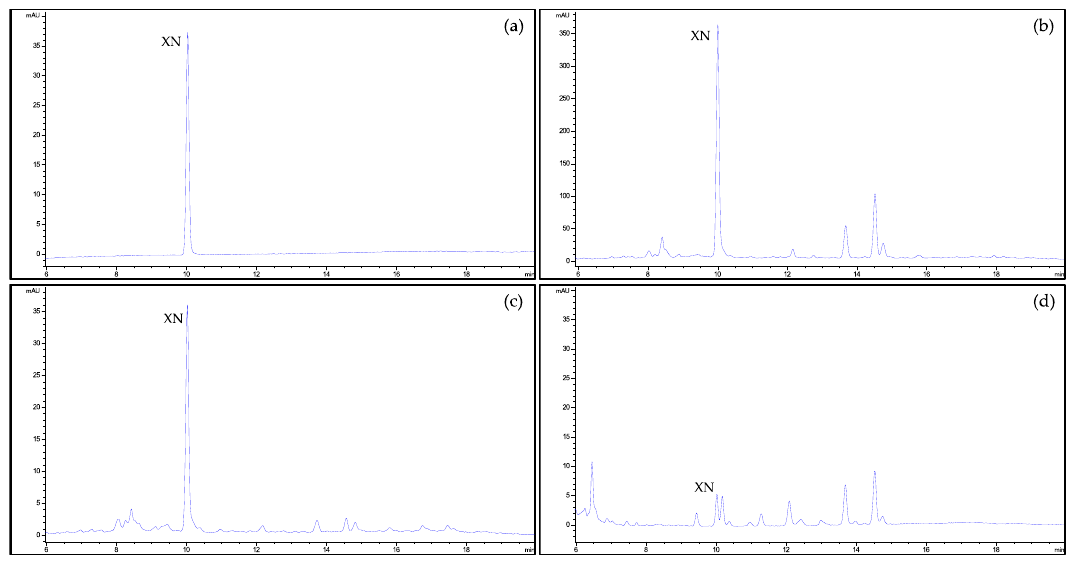
Figure 2. HPLC-DAD chromatograms monitored at 370 nm for xanthohumol (XN) determination: ( a ) standard of XN at 1 mg/L; ( b ) hops; ( c ) food supplement D; and ( d ) beer E.